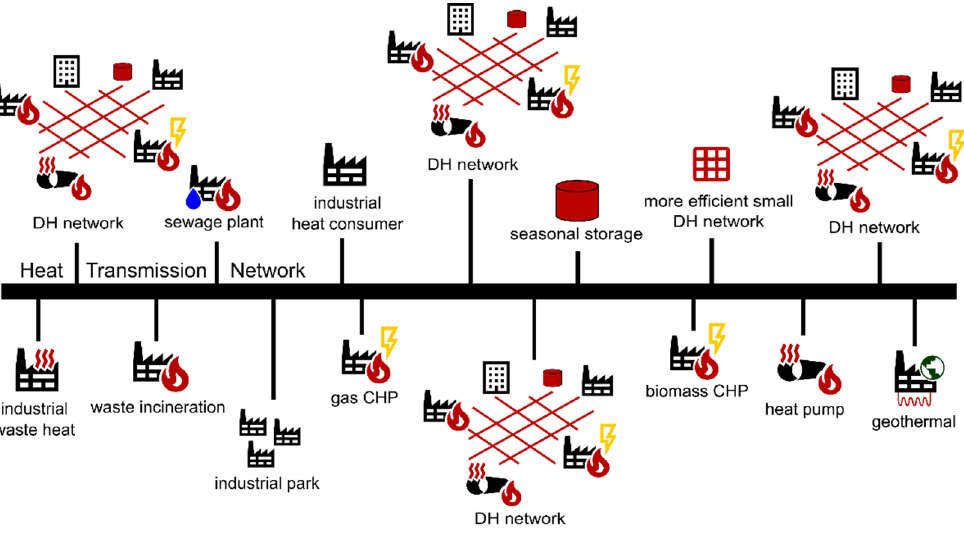
Figure 1. Scheme of a supra-regional district heating network (SR-DHN), interlinked by the superior heat transmission network, which constitutes the backbone. The scheme is based on existing and contemplated components of the case study described in Section 4.1.